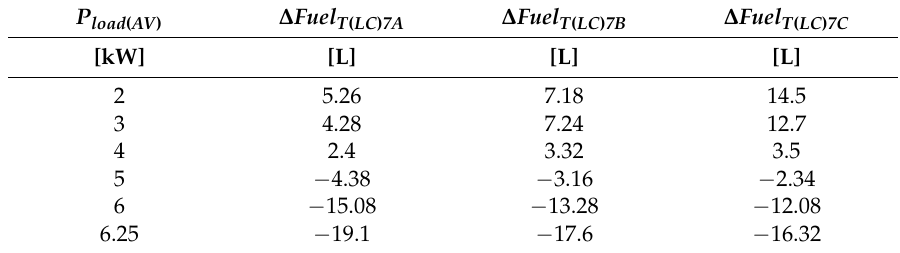
Table 11. Fuel economy under variable load demand for the RTO3 strategy using different k fuel